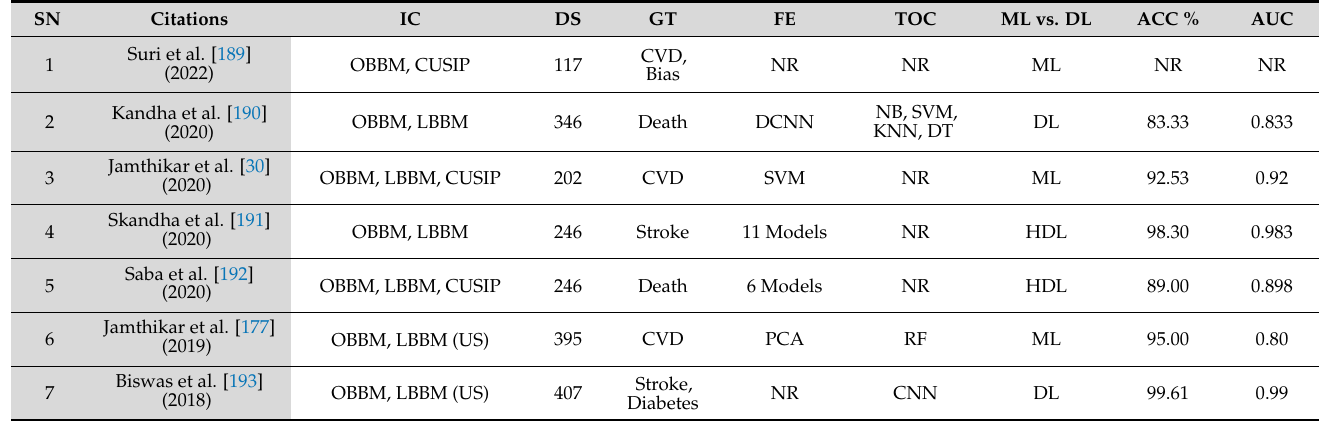
Table 3. The table shows the prediction of CVD by using AI.